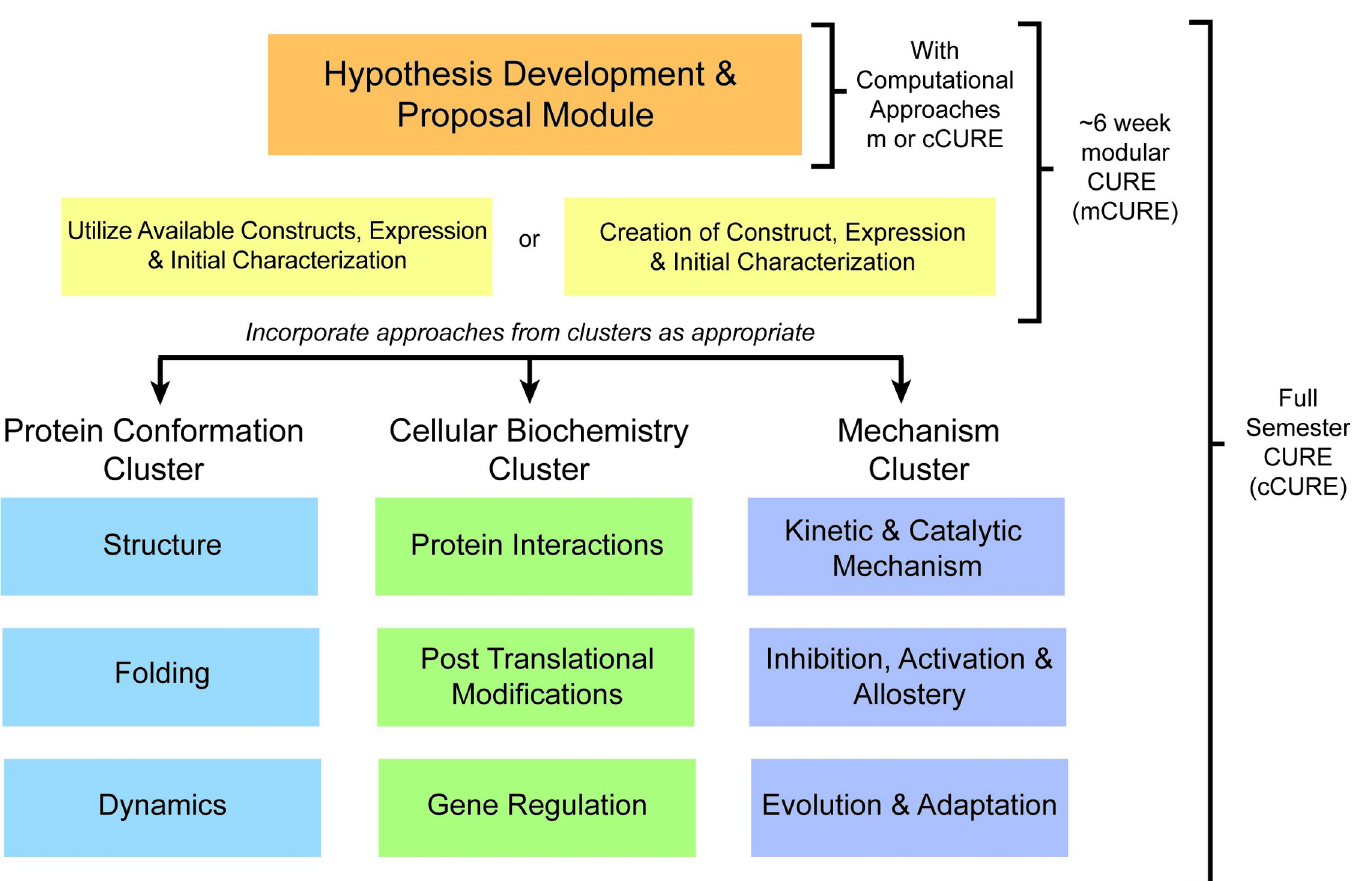
Fig 1. The Malate dehydrogenase CUREs Community (MCC) model. Faculty can implement a malate dehydrogenase focused CURE for a short module within a laboratory course (mCURE) or a full semester (cCURE). All CUREs start with the hypothesis module. There are three experimental clusters: Protein Conformation, Cellular Biochemistry, and